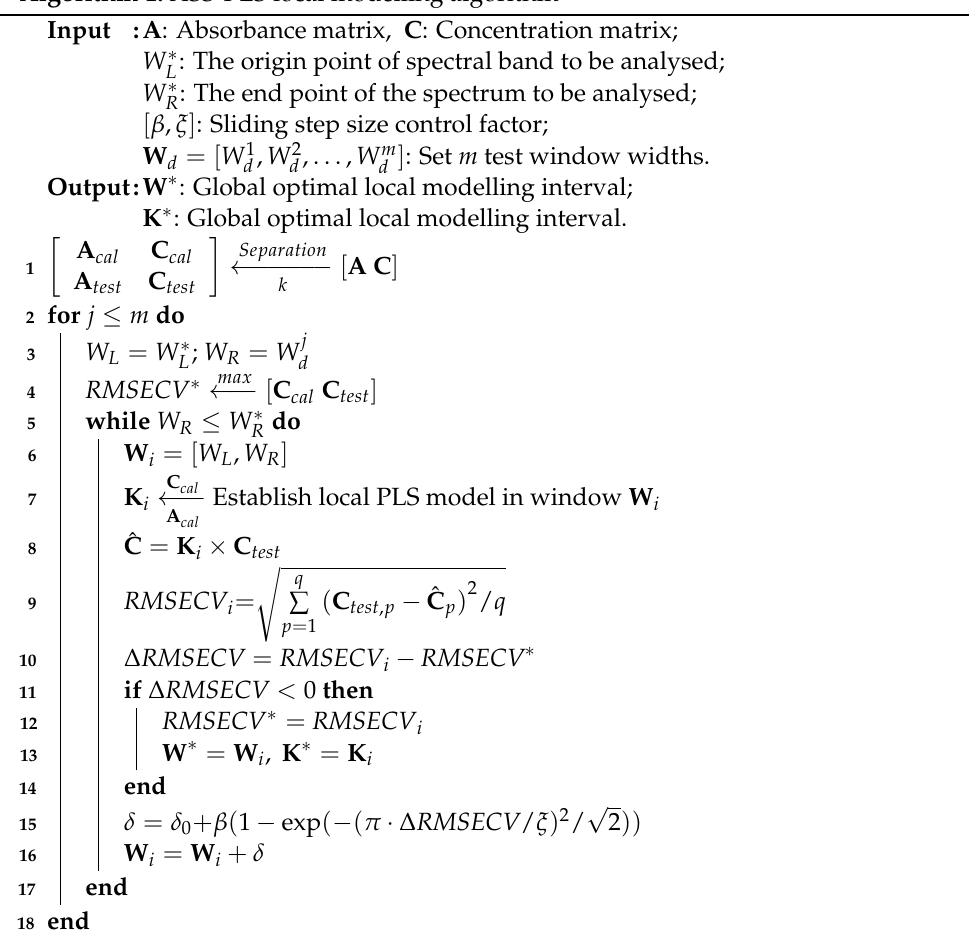
Algorithm 1: ASS-PLS local modelling